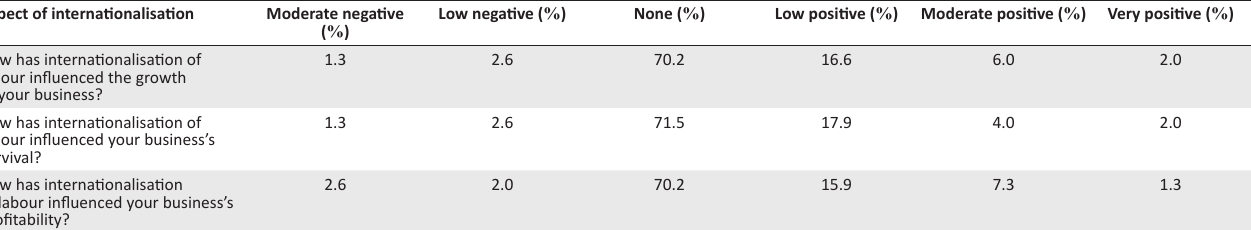
TABLE 7: Extent to which internationalisation of labour has positively or negatively influenced profitability, growth and the survival of business ( N = 151). Aspect of